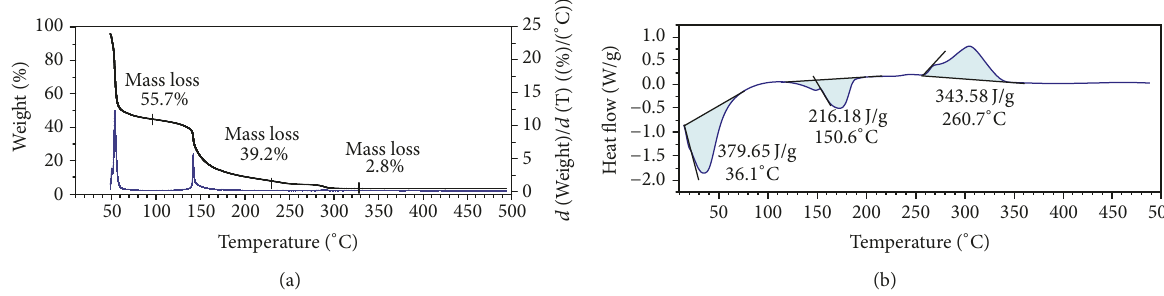
Figure 2: Thermal analysis curves of the formulated ink: (a) thermogravimetric curve and (b) differential scanning calorimetric curve.